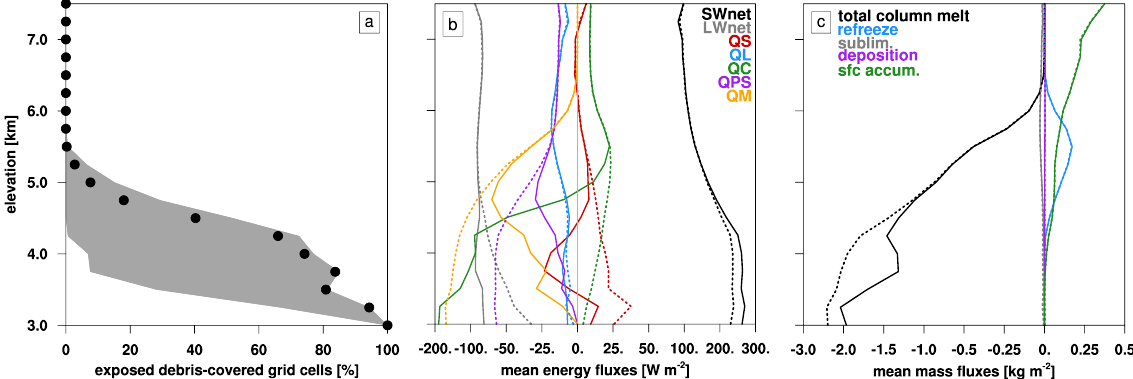
Figure 6. (a) The percentage of debris-covered pixels in each 250m elevation bin that are exposed on average between 1 July and 15 September 2004. Minimum and maximum values over the same period are indicated by gray shading. Elevational profiles of mean glacier (b) surface-energy and (c) mass fluxes, in units of Wm − 2 and kgm − 2 respectively, with the solid (dashed) lines denoting data from DEB (CLN). For (c) , evaporation and condensation in DEB are not shown as their profiles are approximately zero (less than 0.02kgm − 2 for all elevational bands). Note that these profiles correspond to an amalgamation of all glacierized grid cells, rather than the mean elevational profile along glacier.